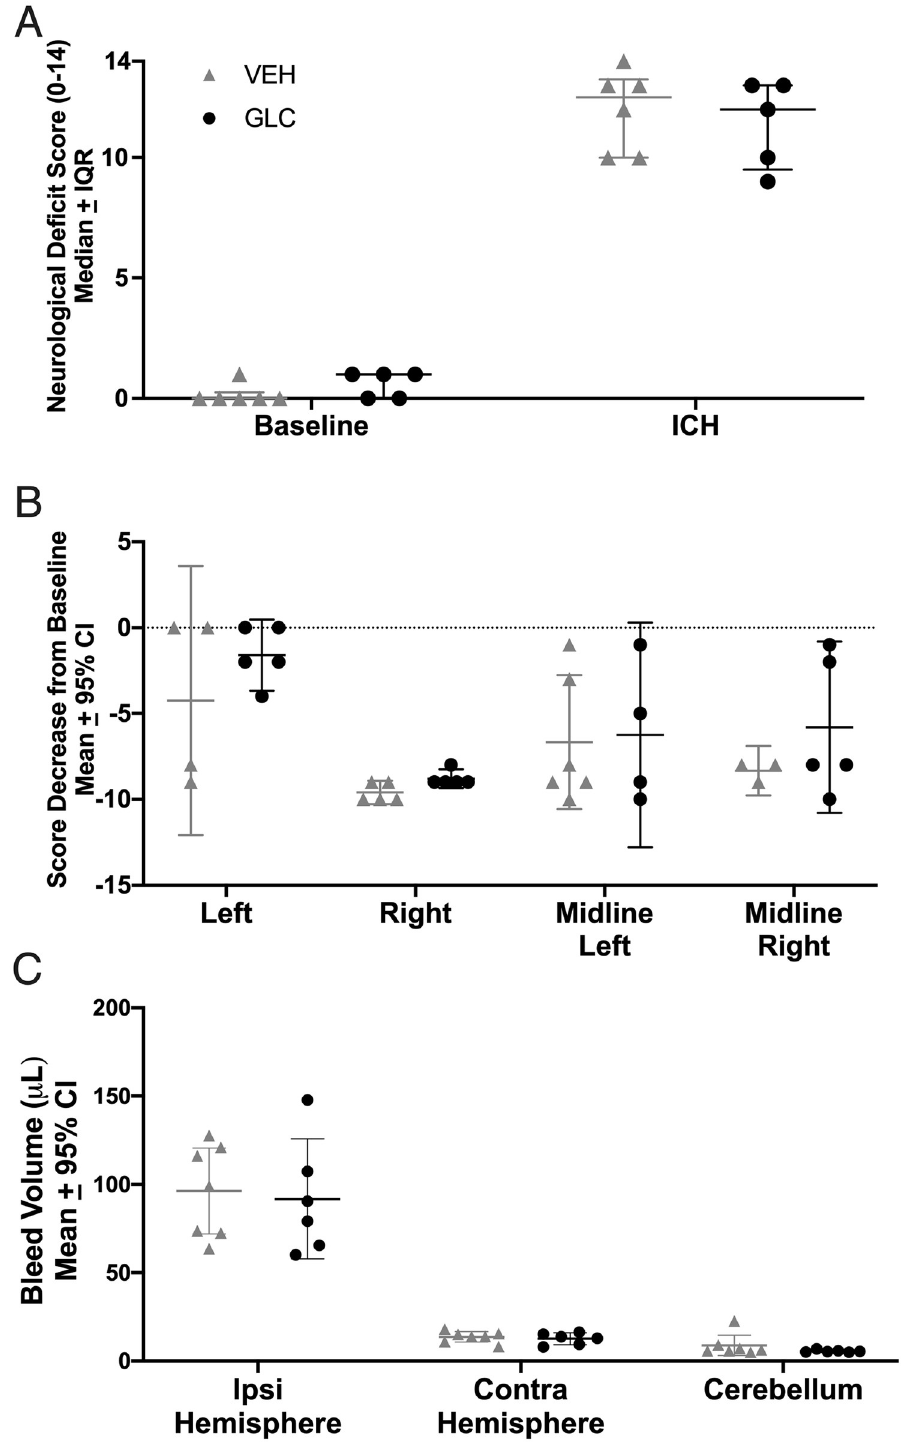
Fig 2. Experiment 1 behaviour and hematoma volume. ICH significantly worsened NDS (A, p < 0.0001) and forelimb placing (B, p < 0.0001) scores for all animals. No benefits of glibenclamide were found in NDS (p = 0.4091), forelimb placing for any paw (p � 0.1190), or hematoma volume (ipsilateral—contralateral hemisphere; C, p = 0.8333). For forelimb placing, a dashed line was set at 0, which indicates no change from baseline. Collagenase caused a significant bleed amounting to 96.2 μ L and 91.7 μ L in the ipsilateral striatum (not adjusted to contralateral hemisphere) of VEH and GLC animals, respectively.